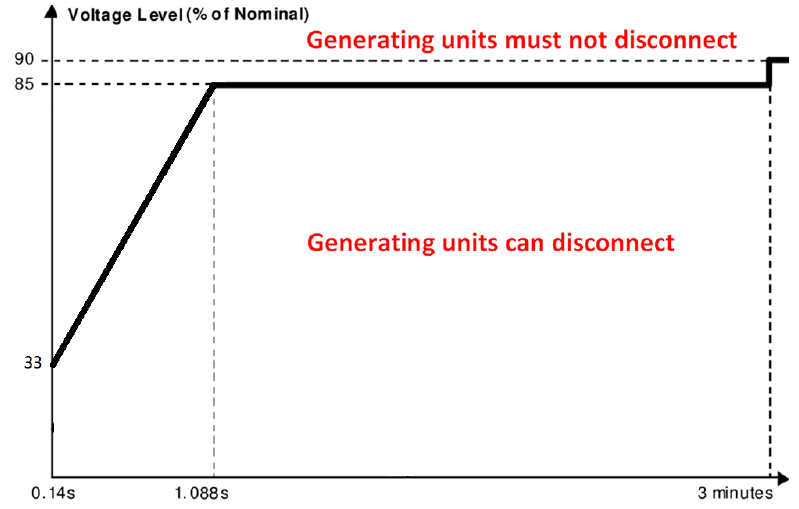
Figure 4. The requirements of FRT/LVRT to synchronous generating units in UK Supergrid (above 200 kV) to the voltage dip on the onshore transmission system duration greater than 140 ms